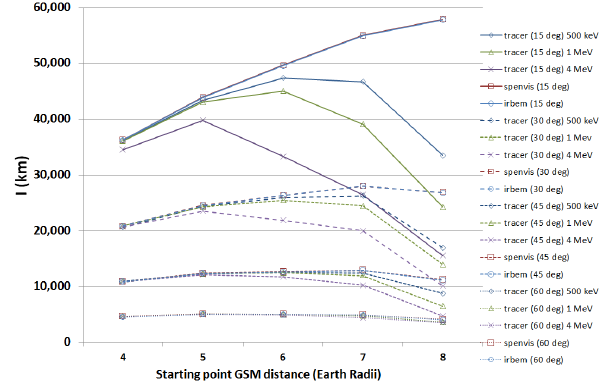
Figure 1. Calculations of I as a function of initial distance (in R E ) at 12:00MLT, for pitch angles of 15, 30, 45 and 60 ◦ and quiet solar wind conditions.